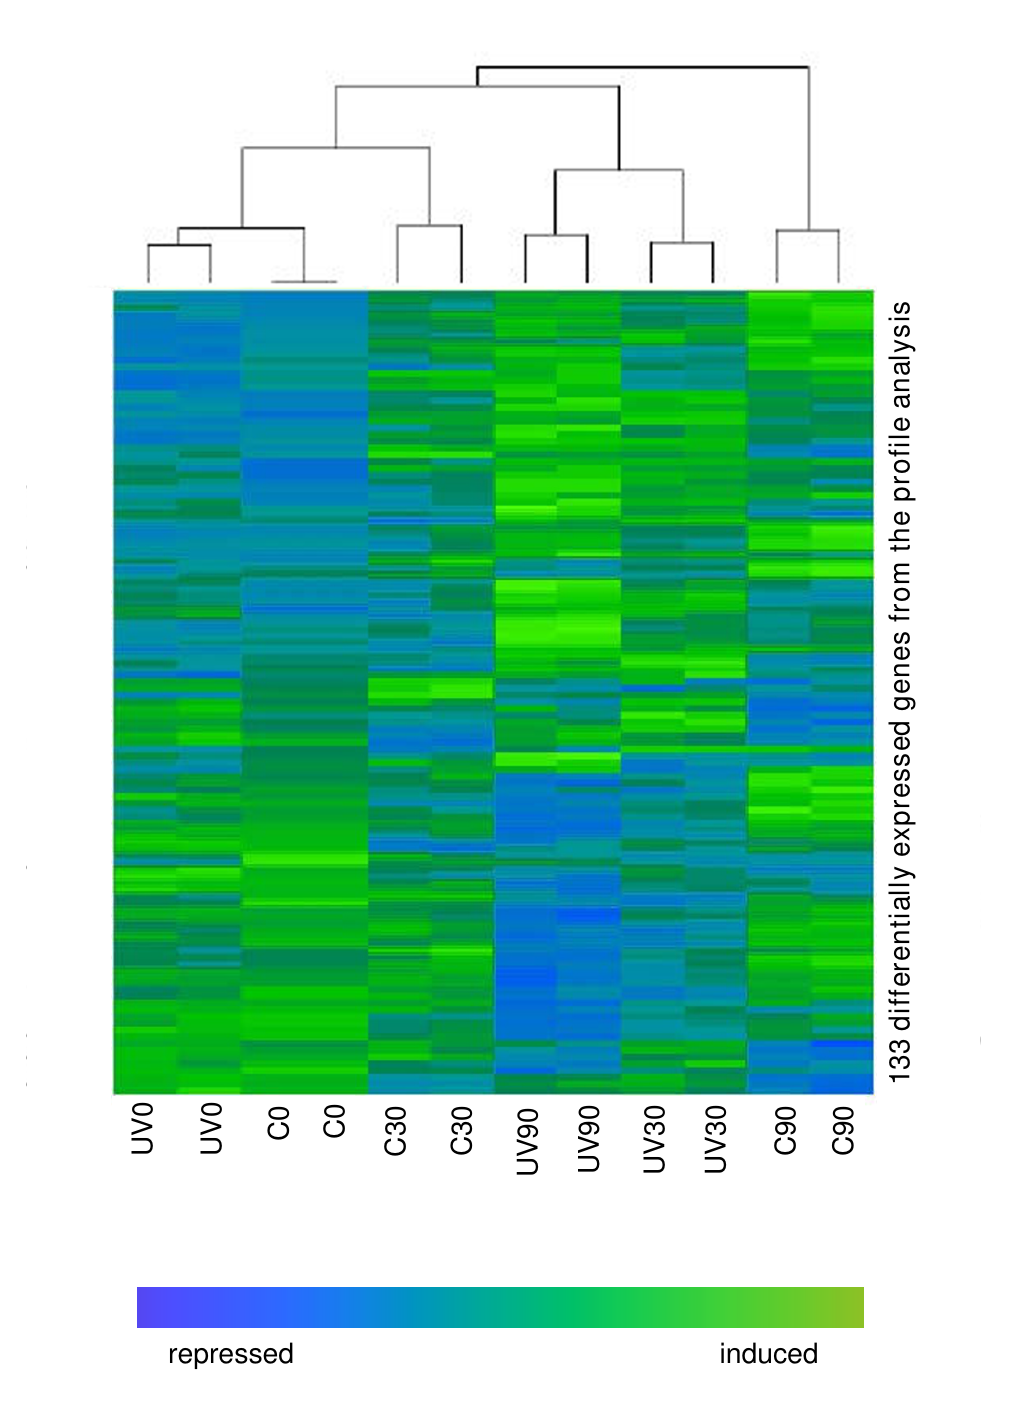
Figure 3 Regulation of gene expression during the time-course experiment in control and UVC-irradiated cells . The expression pattern of 133 genes whose expression changed significantly (P ≤ 0.05) during the time course are shown. The col- umns represent samples taken after 0, 30 or 90 min in control and UVC-irradiated cells. Hierarchical clustering was performed as described in Methods, pairing the 133 genes in the different samples according to their expression level. The changes in tran- scription level are colour coded with induced genes as green and repressed genes as